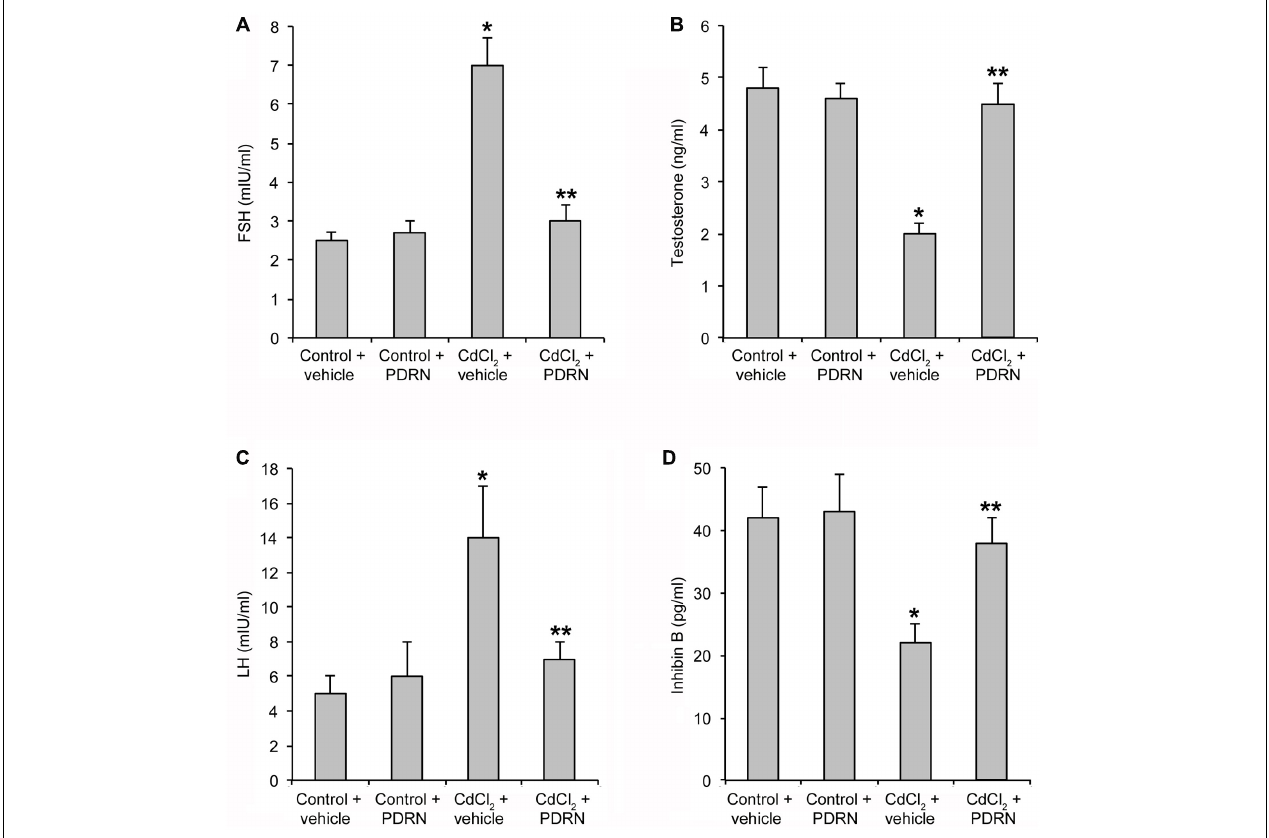
FIGURE 2 | Levels of FSH (A) , TE (B) , LH (C) , and inhibin B (D) in testes collected from control plus vehicle, control plus PDRN (8 mg/kg i.p.), CdCl 2 (2 mg/kg/day i.p.) plus vehicle, and CdCl 2 (2 mg/kg/day i.p.) plus PDRN (8 mg/kg i.p.) treated mice. ∗ p < 0.05 vs. controls; ∗∗ p < 0.05 vs. CdCl 2 plus vehicle. Bars represent the mean ± SE of seven